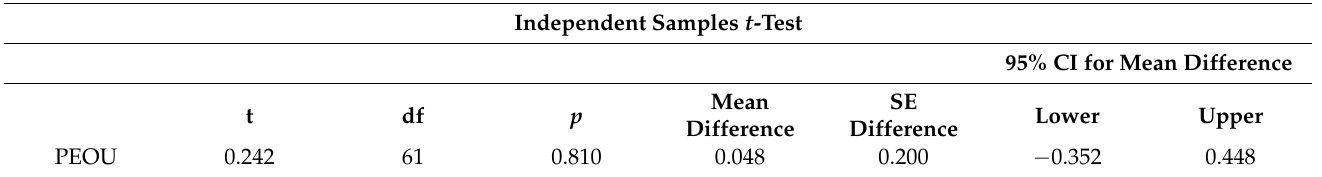
Table 6. Independent samples t -test of perceived